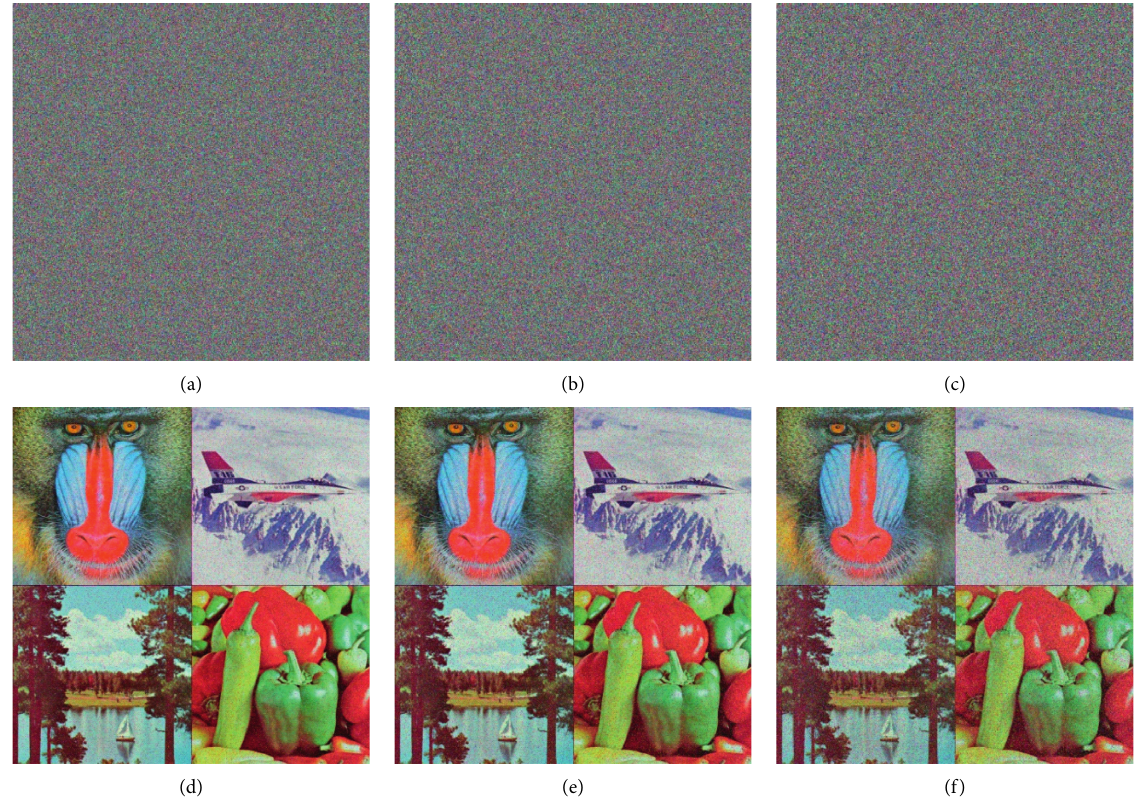
Figure 11: Noise attack. (a–c) Ciphered version of composite image (Figure 4(b)) with S&N noise of varying densities (i.e., 0.1, 0.15, and 0.25) added. (d–f) Recovered versions of the corrupted images.